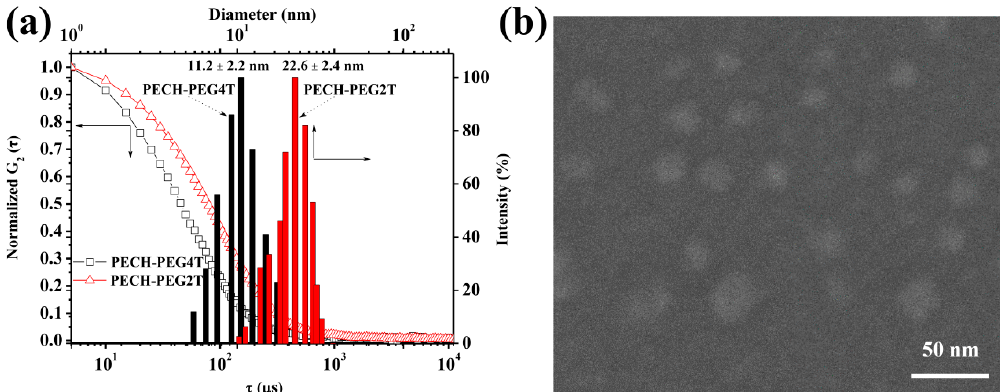
Figure 1. ( a ) Correlation functions and hydrodynamic size distributions of PECH ‐ PEG4T and PECH ‐ PEG2T in water measured at 25 °C. ( b ) SEM image of PECH ‐ PEG4T film spin ‐ coated onto a silicon wafer at 25 °C.